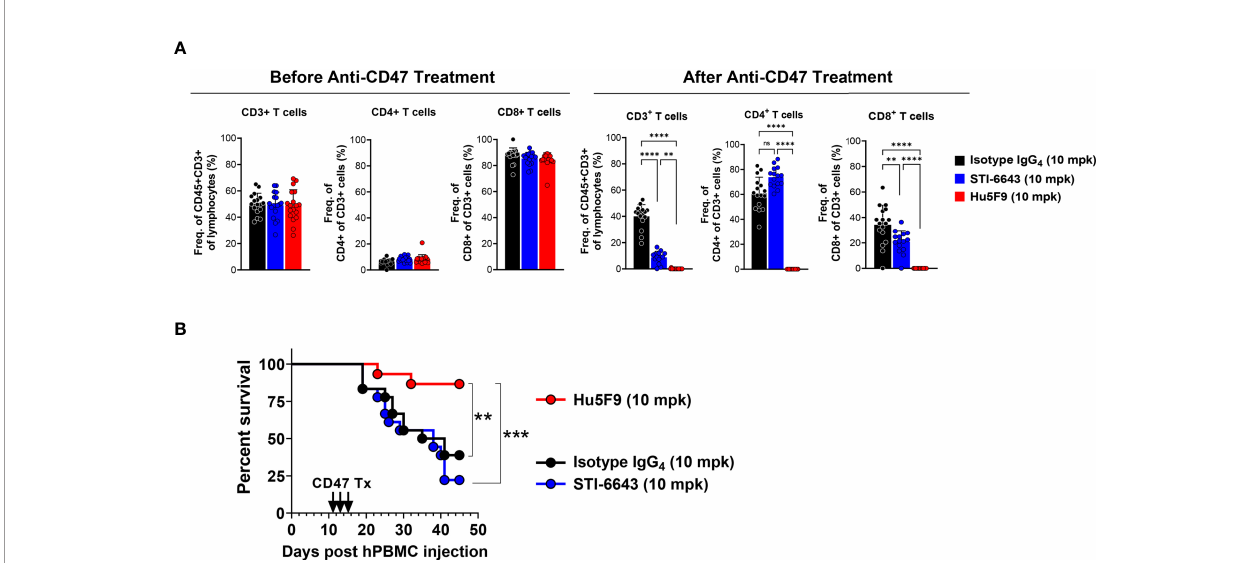
FIGURE 8 | STI-6643 signi fi cantly preserved T cell function in a xenograft GVHD model. Immuno-de fi cient mice were engrafted with human PBMCs and subsequently treated with three doses (on days 11, 13 and 15) of either anti-CD47 clones STI-6643 or Hu5F9 or isotype IgG 4 control antibodies at 10 mg/kg/dose. (A) Analysis of circulating T cells showing frequency of CD3 + , CD4 + and CD8 + T cells before (d10, left panels) and after (d19, bottom panels) treatment. (B) Kaplan- Meier survival graph of mice with different treatments (n = 9 mice/group). Statistical signi fi cance assessed by one way ANOVA (A) and log-rank Mantel-cox test (B) ; (not signi fi cant [ns], *p ≤ 0.05, **p ≤ 0.01, ***p ≤ 0.001, ****p ≤